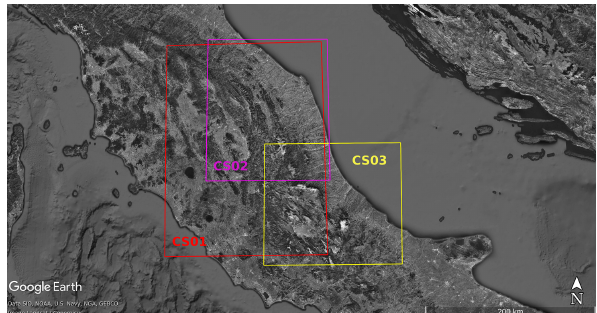
Figure 6. Three CHyM geographical domains used for the simula- tion of the corresponding CSs. The red square encloses the Umbria region and the rest of Tiber basin for CS01; the pink square refers to CS02 (Marche region), and the yellow square encompasses the Abruzzo region for CS03. © Google